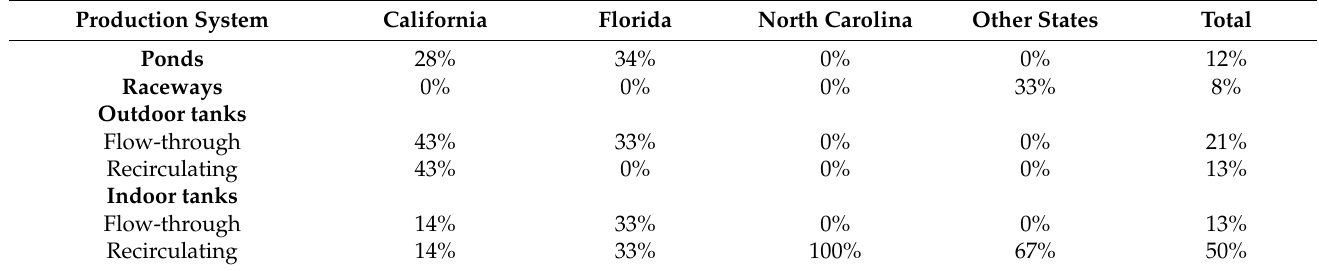
Table 2. Percent of farms with ponds, RAS, and outdoor tanks (flow-through and recirculating). Percentages in columns do not add to 100% because many tilapia farms used more than one type of production